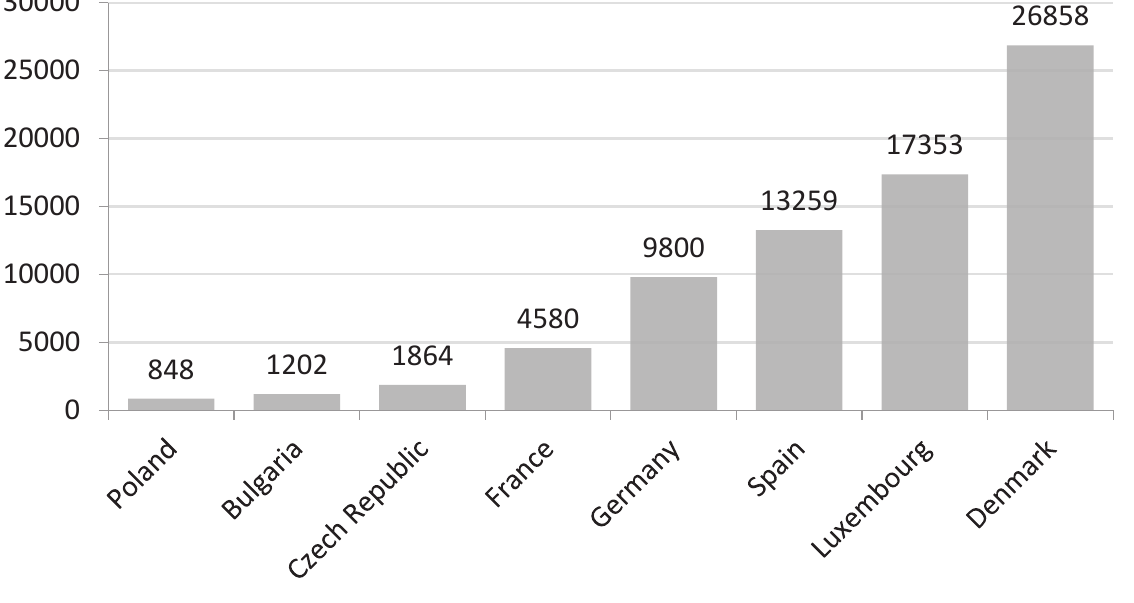
Figure 1. Average price of agricultural land in EU countries, euro/hectare